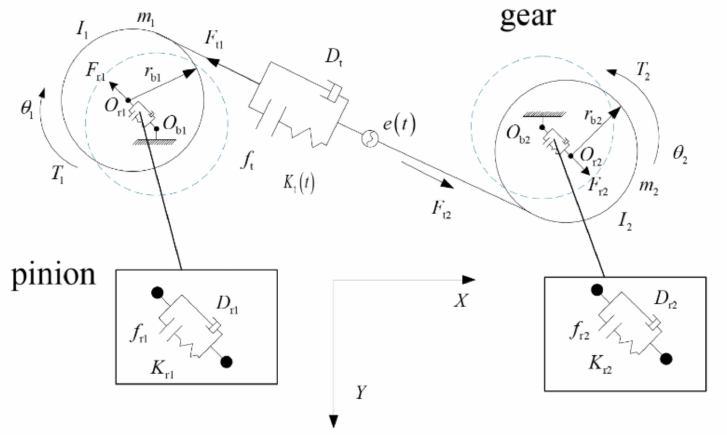
Figure 1. System description of an involute spur gear pair with gear backlash and bearing